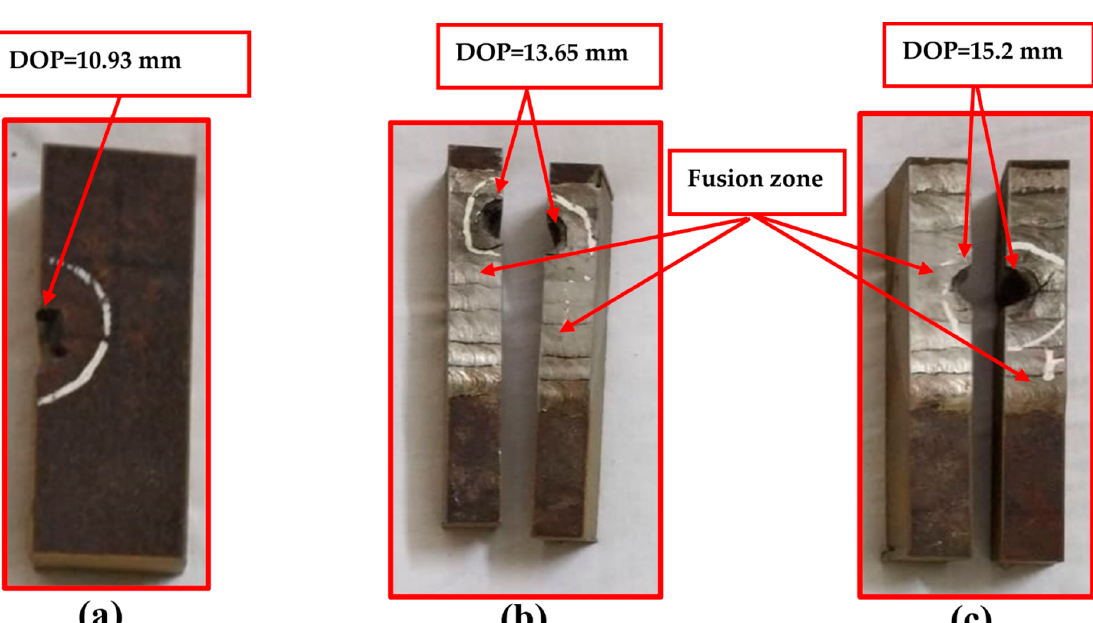
Figure 7. 7.62 AP bullet penetration cut section of ( a ) base metal, ( b ) weldment-1, ( c ) weldment-2.